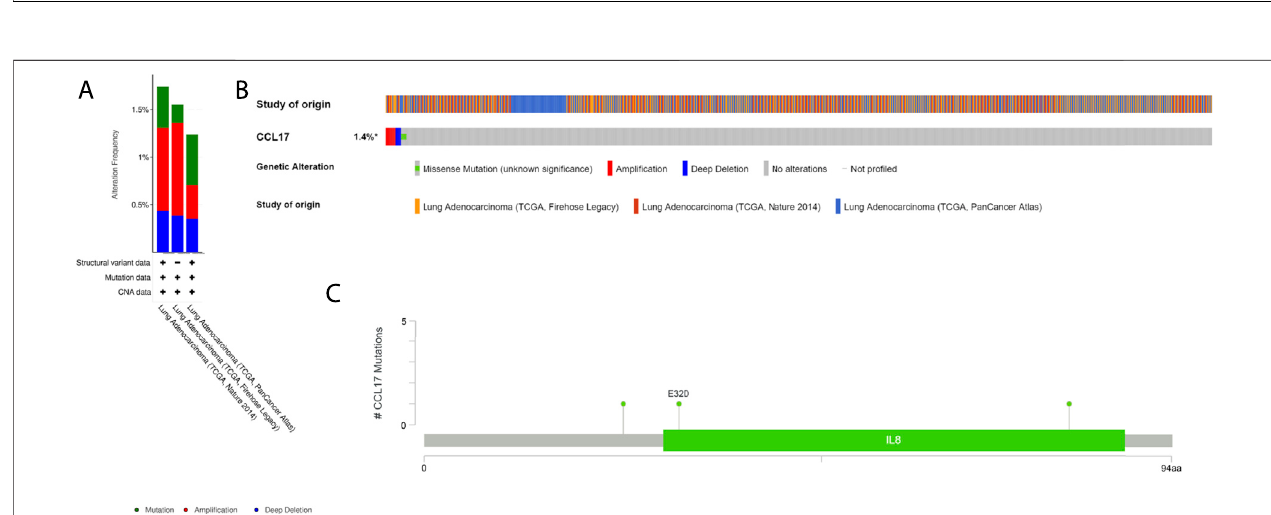
FIGURE 12 | Mutation status view of CCL17 in LUAD. (A) Histogram of the alteration frequencies of CCL17 in LUAD studies. (B) OncoPrint tab summarizes genomic alterations in CCL17 across a sample set. Each column represents a tumor sample. Red bars indicate gene ampli fi cations, blue bars are deep deletions, and green squares are missense mutation. (C) Graphical view shows the Pfam protein structural domain and speci fi c mutation sites of CCL17.